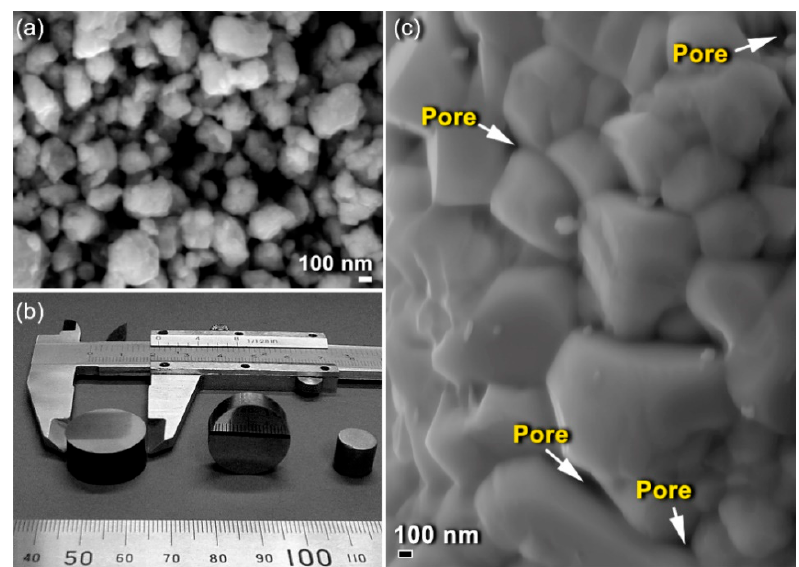
Figure 5. ( a ) Field-emission scanning electron microscope (FE-SEM) micrograph of fcc-ZrN powders obtained after 259 ks of RBM; ( b ) the outer shape view of the as-consolidated powders through SPS; ( c ) surface fracture of the consolidated sample.